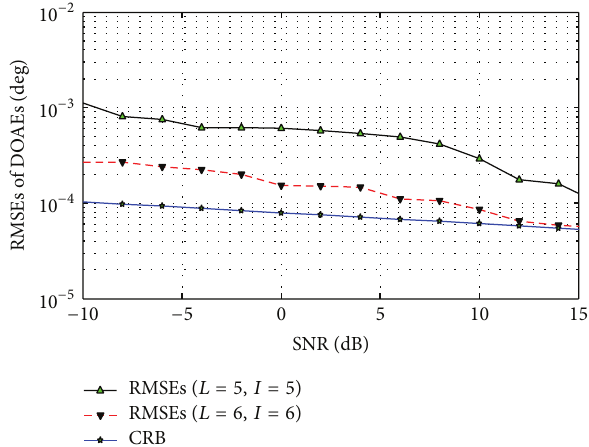
Figure 5: RMSEs versus SNR of T-ESPRIT with different number of elements for stationary target.